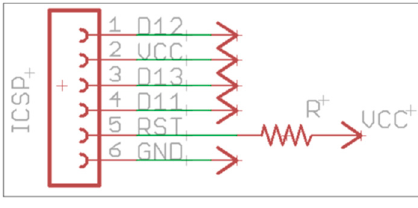
Figure 8. Programing interface.